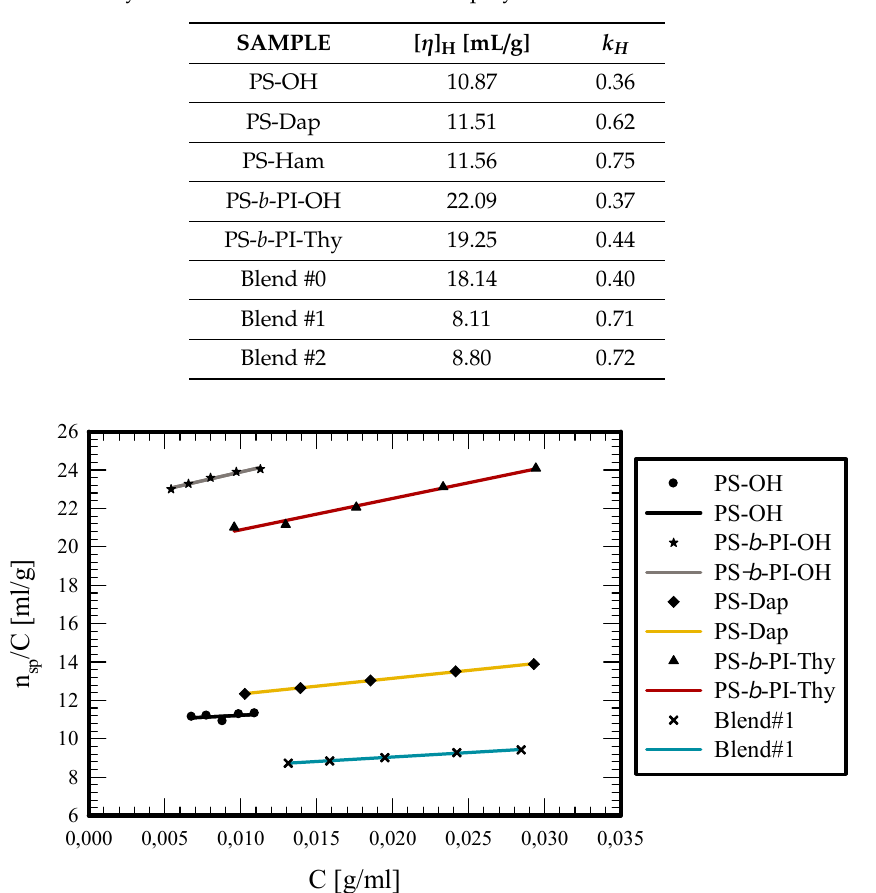
Table 3. Viscometry results of the end-functionalized polymers and the blends in Toluene at 25 ◦ C.